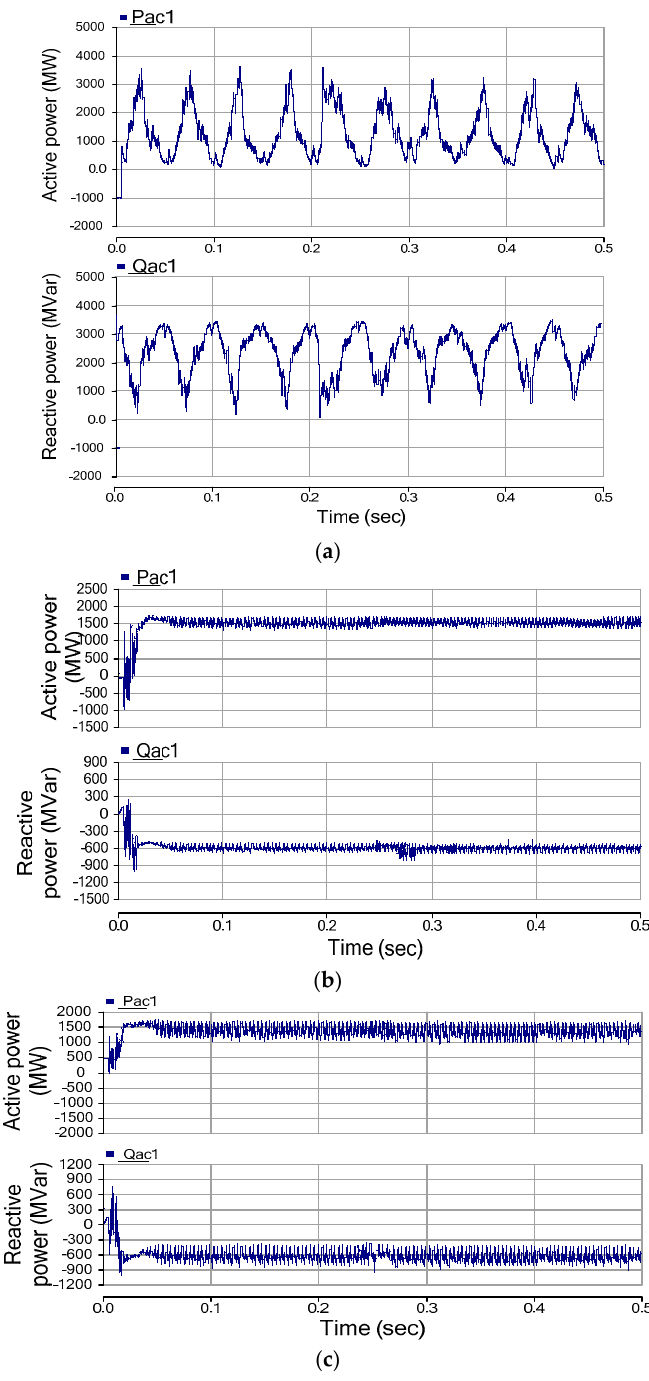
Figure 15. Line frequency side simulation results: ( a ) Single ‐ phase system; ( b ) Two ‐ phase system; ( c ) Three ‐ phase system.